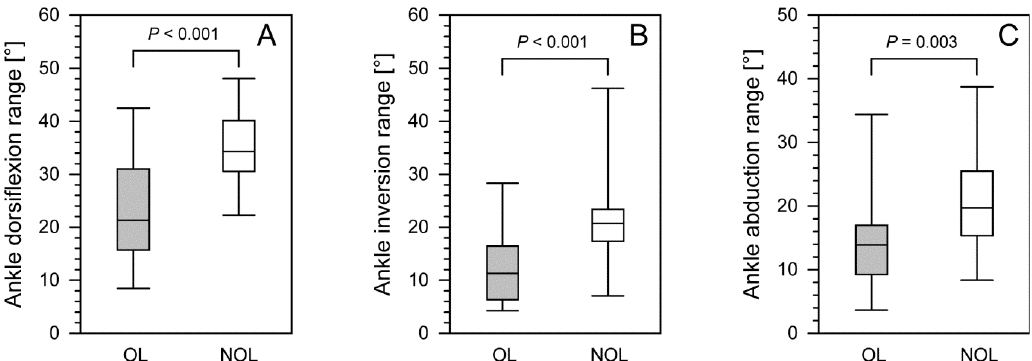
Figure 4. The comparison of ankle dorsiflexion range ( panel A ), ankle inversion range ( panel B ), and ankle abduction range ( panel C ) between operated and non-operated limbs for patients after treatment with the Ilizarov method. The lower border of each box indicates the 25th percentile, the line within the box marks the median, and the upper border of each box indicates the 75th percentile. The whiskers above and below the boxes indicate the 90th and 10th percentile, respectively. Filled box, operated limb (OL); white box, non-operated limb (NOL).